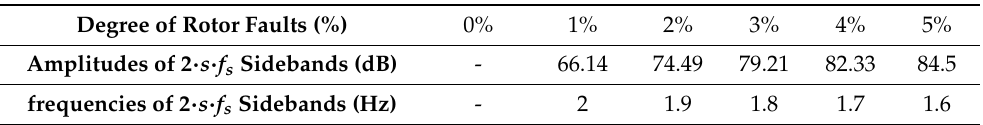
Table 4. Amplitudes and frequencies of the 2· s · f s spectral components at nominal load and under different degrees of rotor fault conditions.